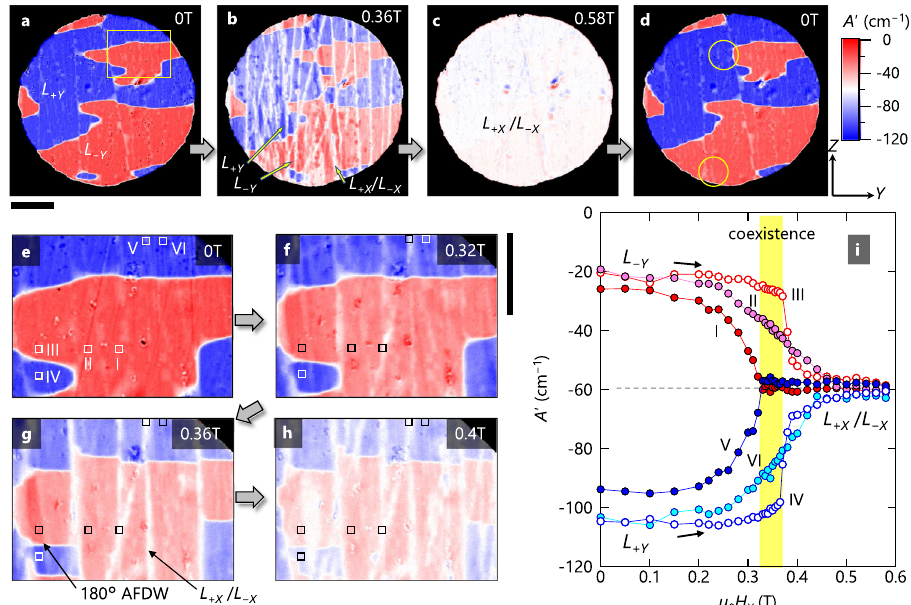
Fig. 5 Demonstration of antiferromagnetic trichroism. a – d A sequence of A ʹ images of an X -plane sample for k X > 0 at 5 K in varying applied fi elds ( μ 0 H Y ) of 0 T ( a ), 0.36 T ( b ), 0.58 T ( c ), and then 0 T ( d ). Here, A ʹ is the variation of absorption coef fi cient from 50 K (> T N ). E ω is parallel to the Y axis and light wavelength is 750nm. The domain pattern at 0 T is slightly changed once μ 0 H Y of 0.58 T is applied, as denoted by yellow circles in (d). Scale bar below (a) is 0.2 mm. e – h A sequence of magni fi ed images of the yellow-box region in (a) in varying μ 0 H Y of 0 T ( e ), 0.32 T ( f ), 0.36 T ( g ), and 0.4 T ( h ). In ( g ), a boundary separating L + Y (blue) and L − Y (red) domains corresponds to a 180° antiferromagnetic domain wall (AFDW). A L + X / L − X domain ( L + X or L − X or both) is pointed by a black arrow. Scale bar next to ( f ) is 0.1 mm. i The μ 0 H Y dependence of A ʹ at regions I – VI de fi ned in ( e ). The yellow